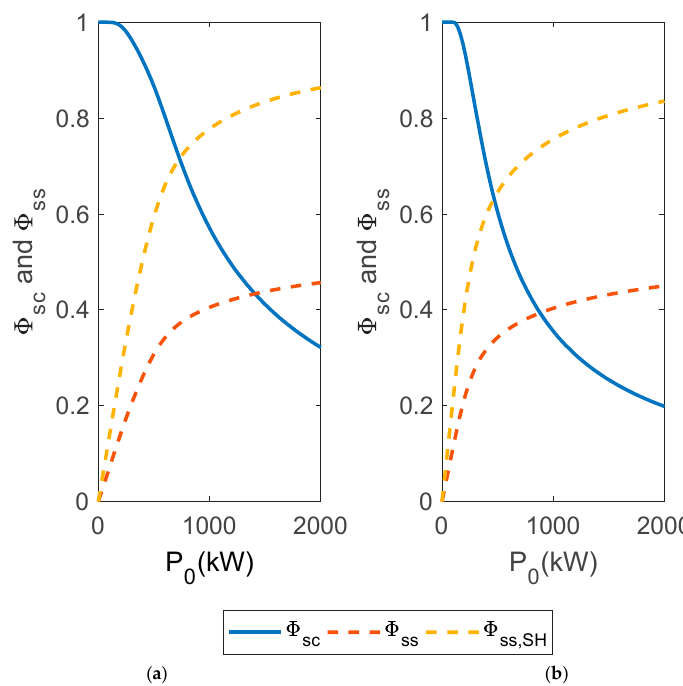
Figure 11. Annual self-consumption and self-sufficiency curves calculated with total hours (24h) and sunshine hours. ( a ) Industry A; ( b ) Industry B.